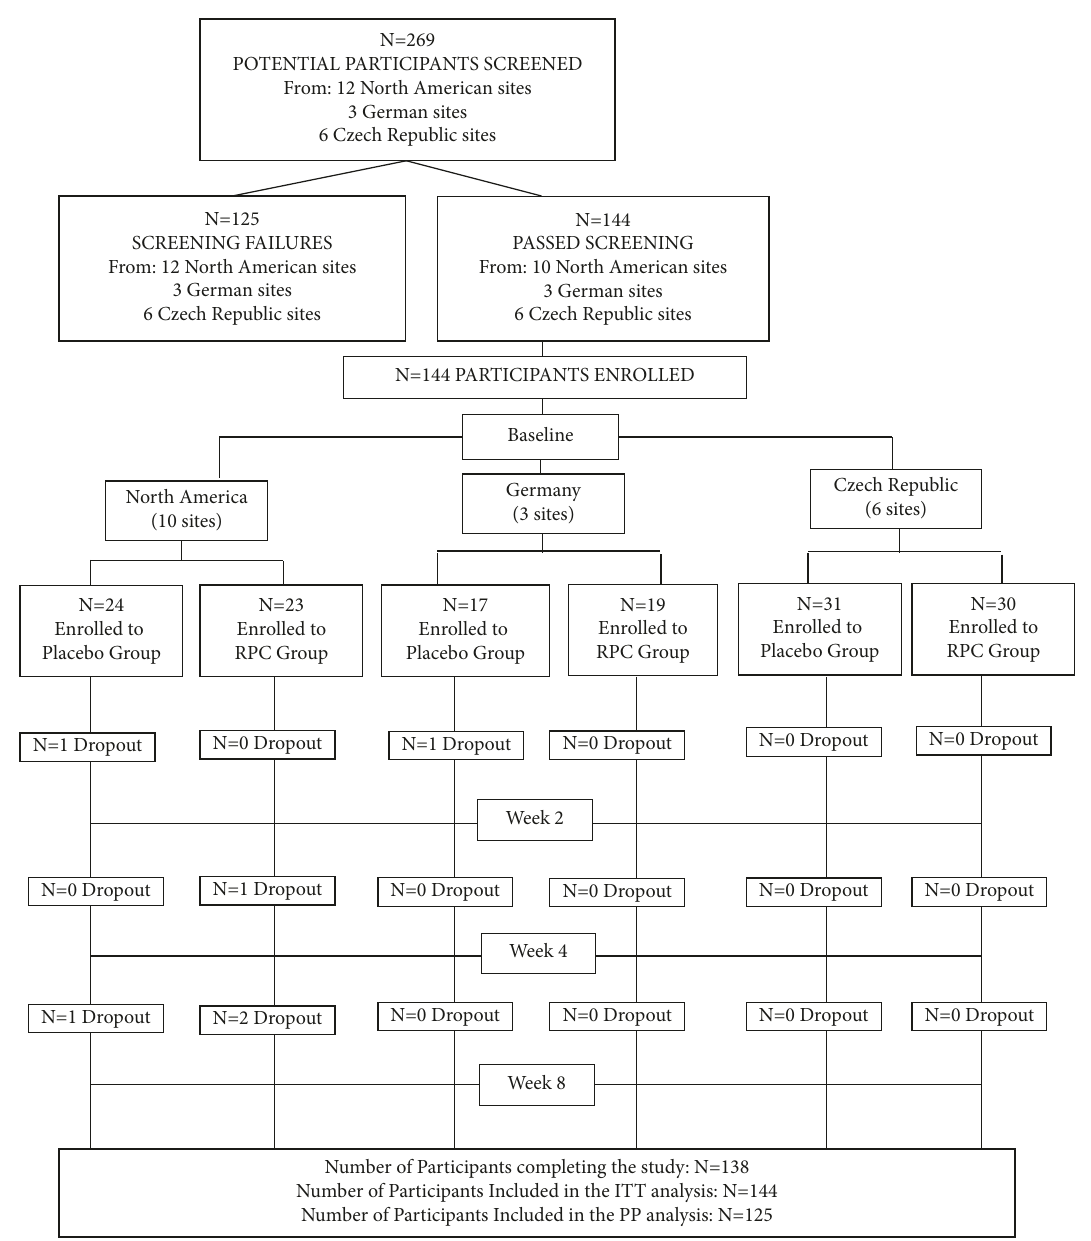
Figure 1: Flowchart of study